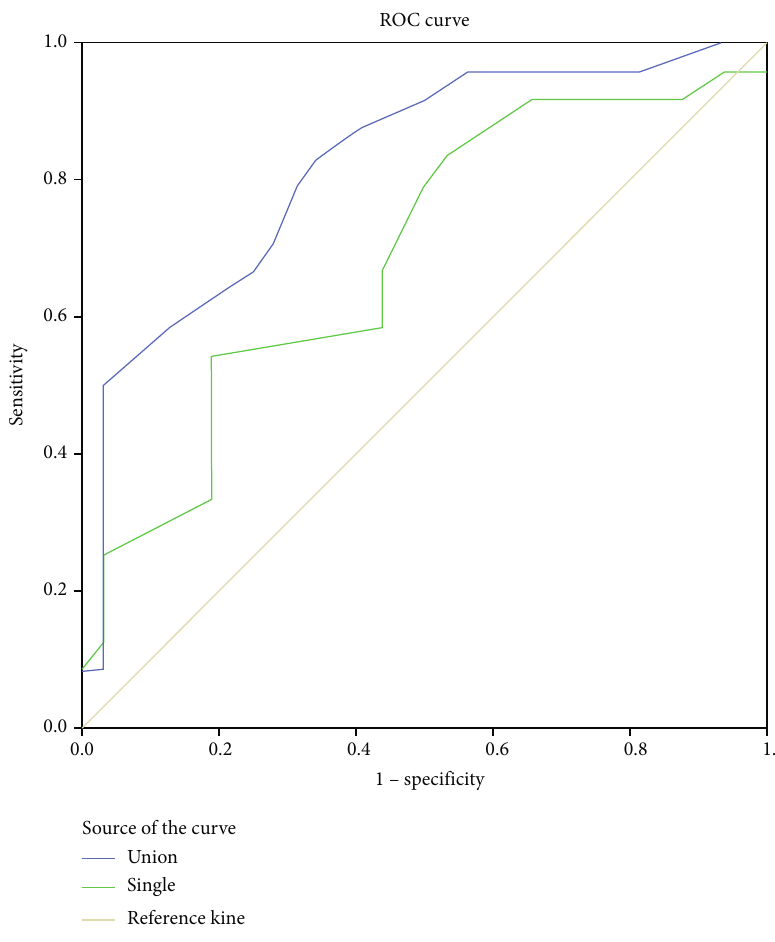
Figure 2: ROC curves derived from US and US+ECUS in the diagnosis of benign and malignant thyroid